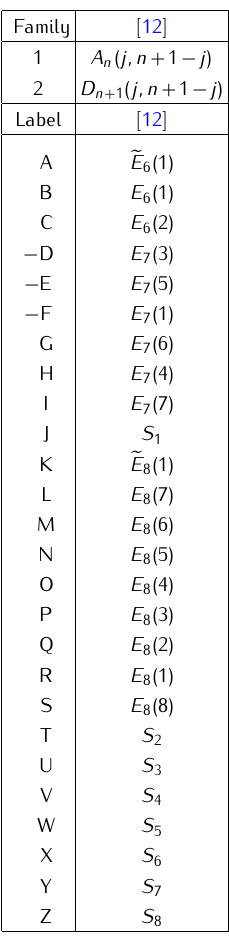
Table 5. Graphs associated to the two infinite families of Table 1 and the 26 sporadic cases of interlacing cyclotomic pairs of Table 2. The second column refers to the graphs of [12, Figures 2,3,5] and the signed graphs S i of Figure